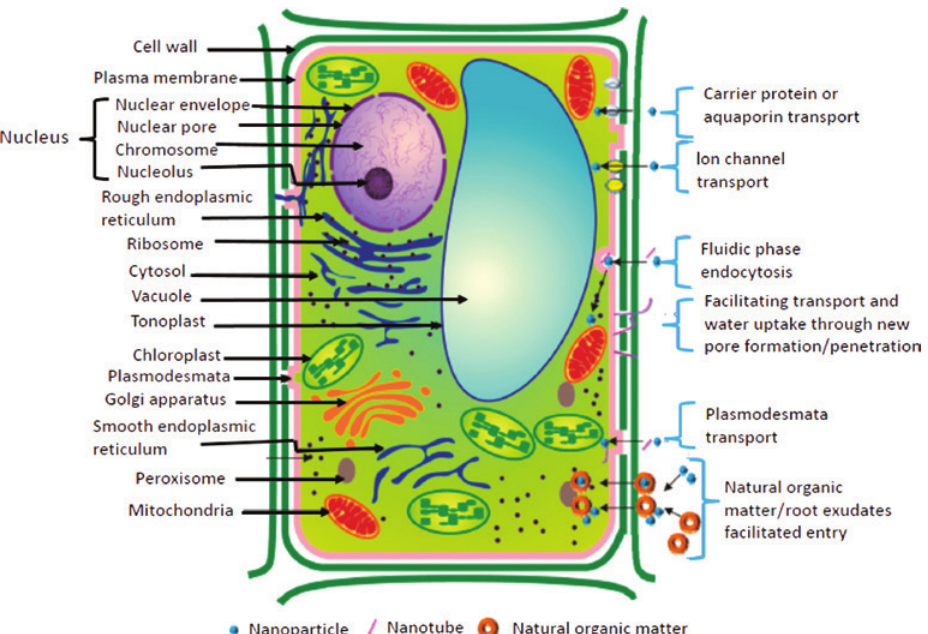
Figure 4: Probable avenues of cellular uptake of the nanoparticles in a plant cell (Reproduced from Rico et al. [65] with permission from American Chemical